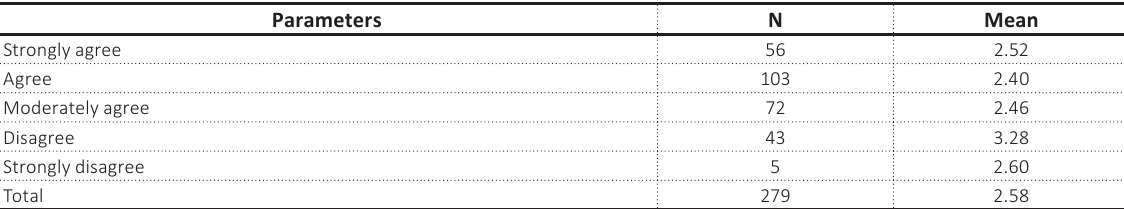
Source: Authors’ estimation